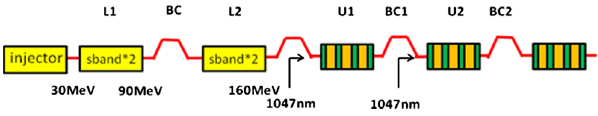
FIG. 7. Layout of SDUV FEL facility for generation of THz density modulation in a chirped electron